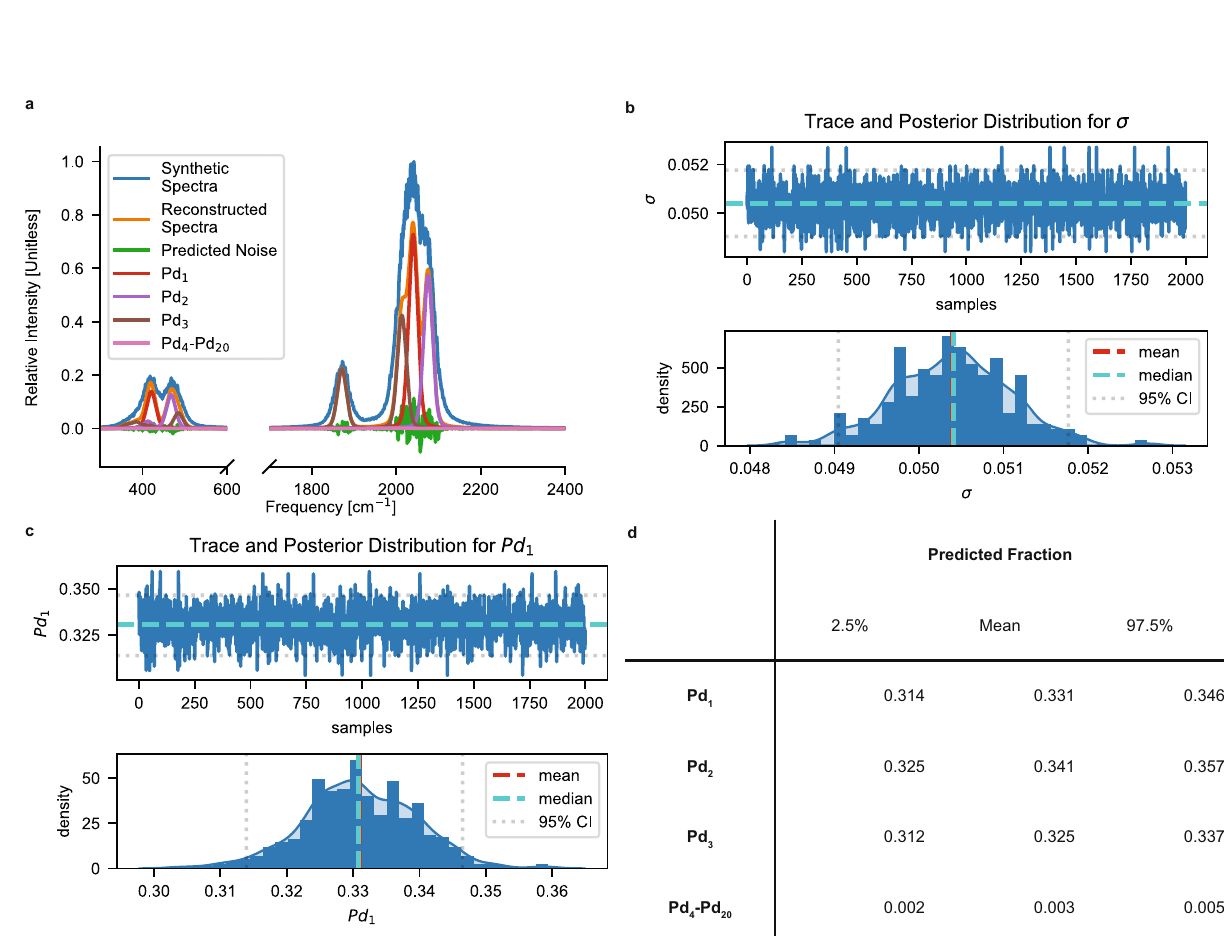
Fig.6|Syntheticspectradeconvolutionofasystemcontainingequifractionsof supported Pd 1 , Pd 2 , and Pd 3 /CeO 2 saturated with CO. a Plotted is the synthetic spectra,reconstructedanddeconvolutedspectra,andthepredictedspectralnoise. The means of the sampled posterior distributions are used as the point estimates for the cluster fractions. The primary spectra of Pd 1 (red) and Pd 2 (purple) contain singlet peaks with severe overlap and form a single peak in the synthetic spectra that is dif fi cult to discern by the naked eye due to noise and spectral broadening.